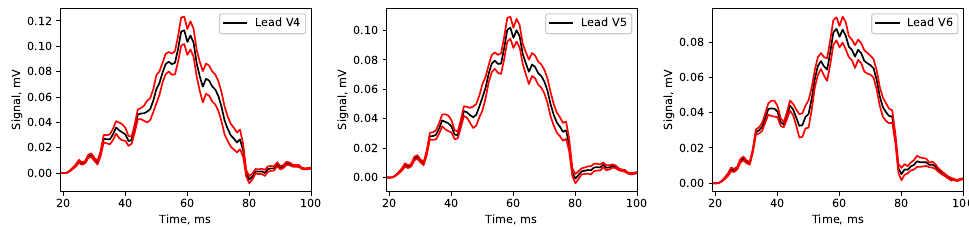
Figure A1. The mean P-wave signal (black) of all leads in DS 3 and its range of ± one standard deviation